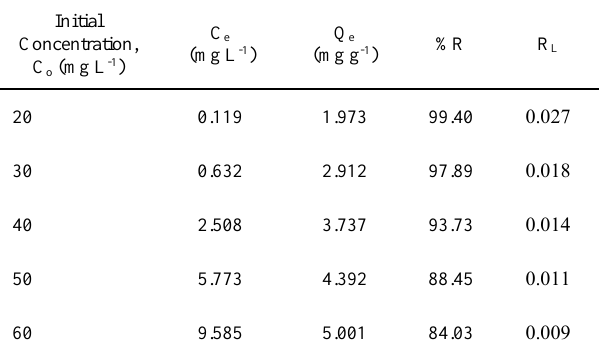
Table 1. Initial concentration (C o ) variation of MB by SHC270 Initial Concentration,